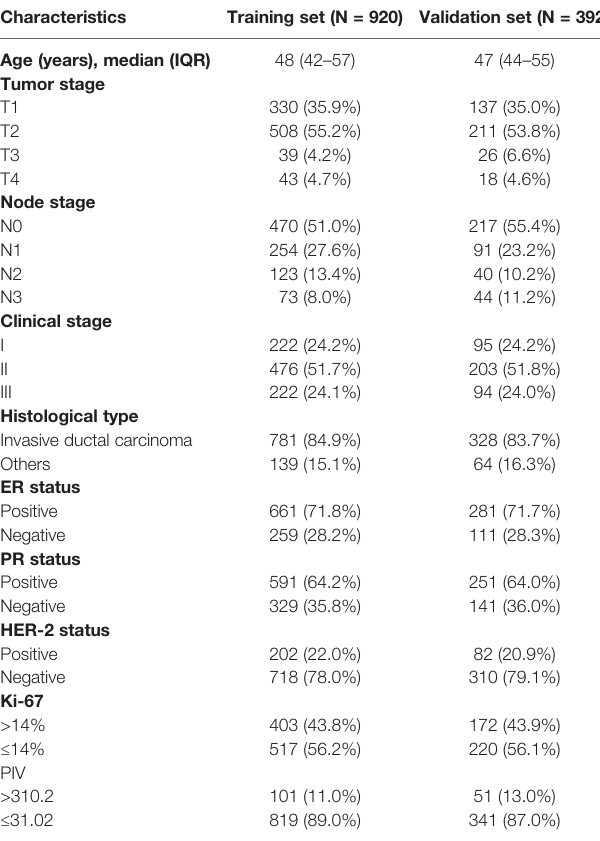
TABLE 2 | The baseline characteristics between the training and validation datasets.